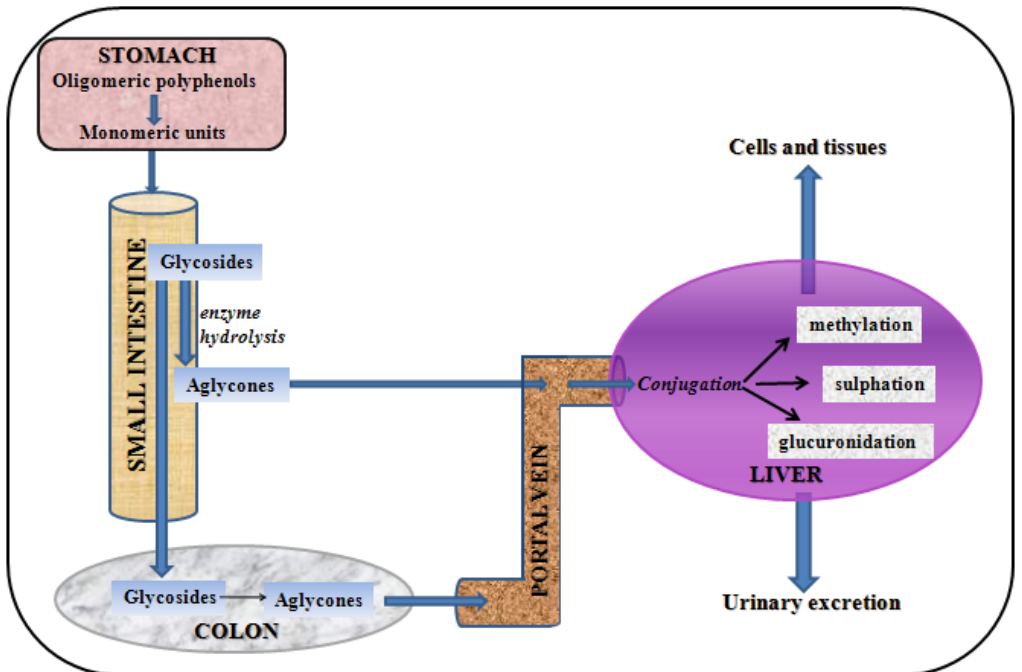
Figure 2. The absorption of dietary polyphenols in humans is schematically